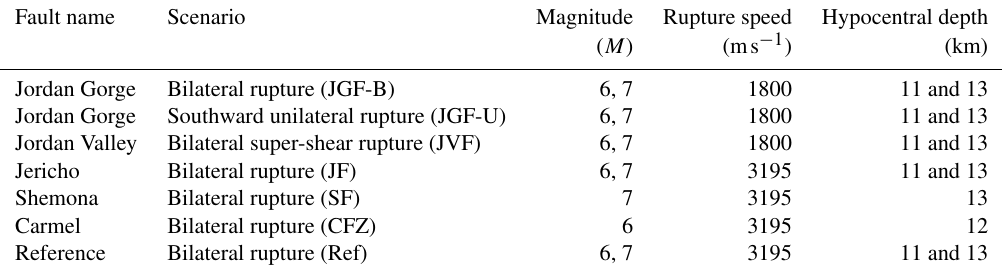
Table 3. Earthquake